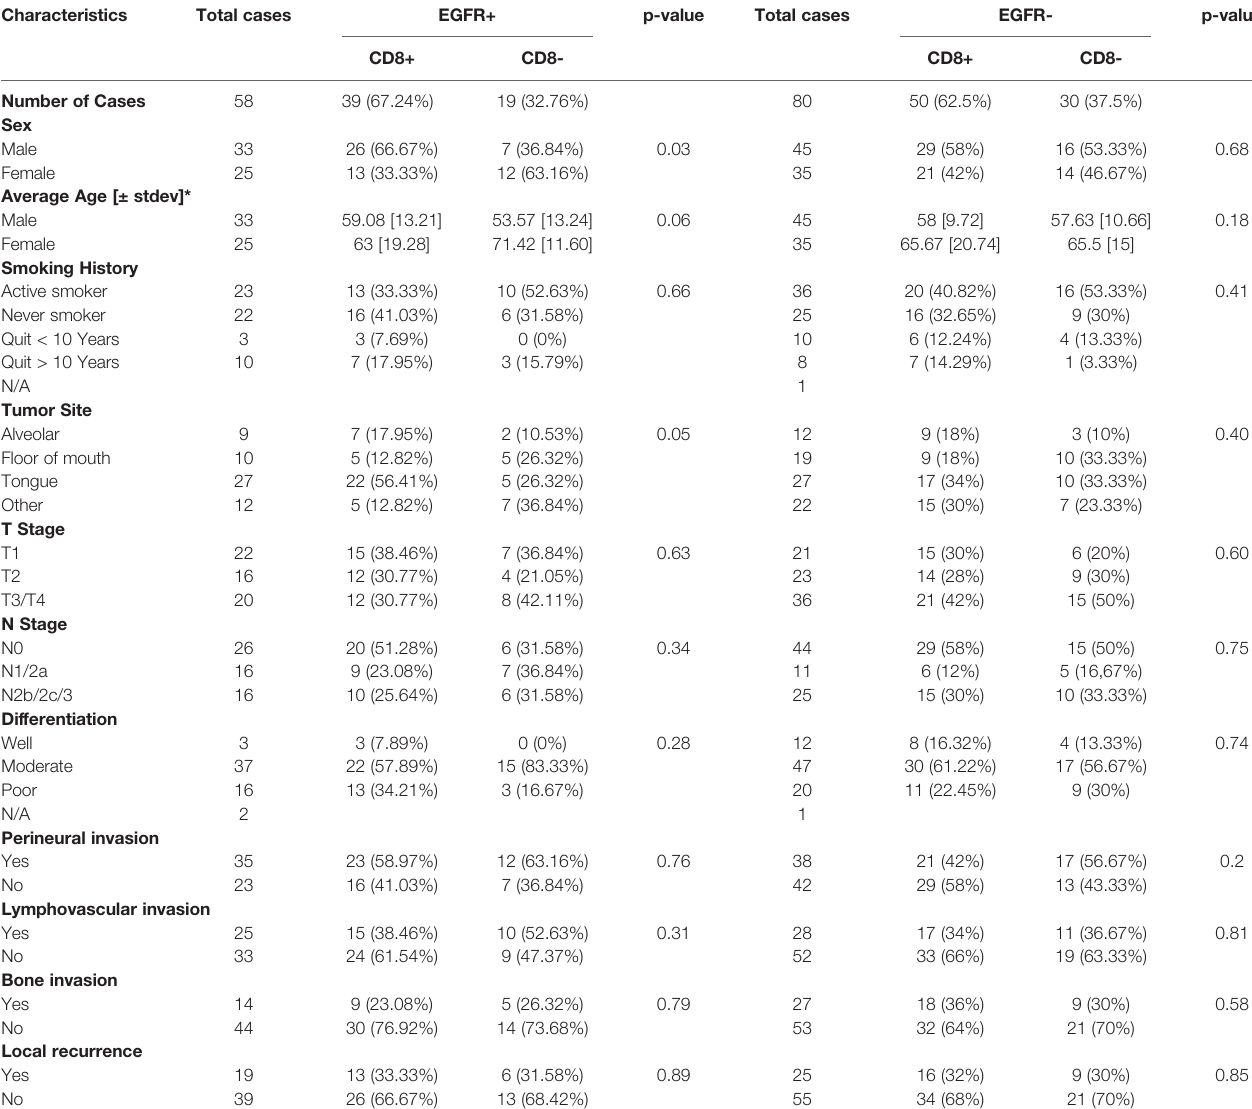
TABLE 5 | Clinicopathological features of patients based on EGFR/CD8 status.